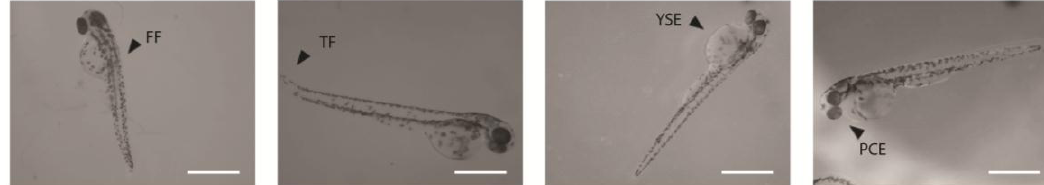
Figure 10. Representative optical images of the four different malformations observed in larvae at 96 hpf treated with oxi-CNOs or oxi-CNHs or GO. FF, fin fold flexure; TF, tail flexure; YSE, yolk sac edema; PCE, pericardial edema. Scale bar = 1 mm.